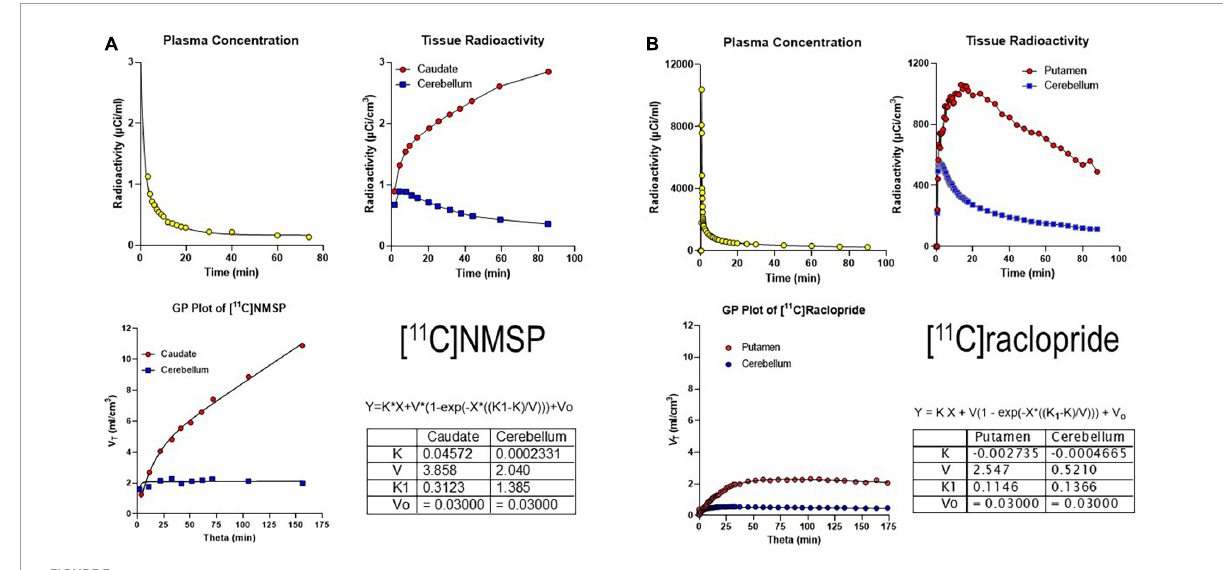
FIGURE3 Irreversibly and reversibly binding radiotracers. (A) Gjedde-Patlak (GP) plot applied to the irreversibly binding radioligand [ 11 C]NMSP. Upper left panel: Arterial plasma time-activity curve (TAC) corrected for metabolites. Upper right panel: Caudate and cerebellum TAC. Lower left panel: GP plot applied to total volume of distribution ( V T ) vs. normalized time (“see Equation 15”). Lower right panel: Parameter output by GP plot. (B) GP plot applied to reversibly binding radioligand [ 11 C]raclopride. Upper left panel: Arterial plasma TAC corrected for metabolites. Upper right panel: Putamen and cerebellum TACs. Lower left panel: GP plot applied to V T vs. Theta. Lower right panel: Parameter output by GP plot. Adapted from Gjedde